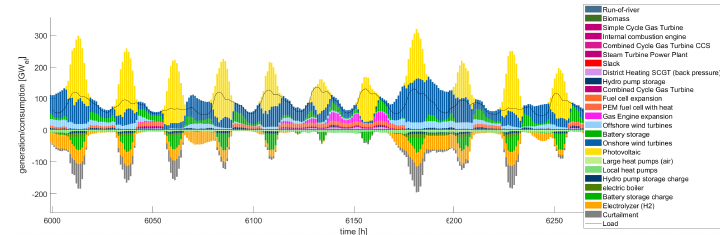
Figure 12. Excerpt of the aggregated electric dispatch in scenario